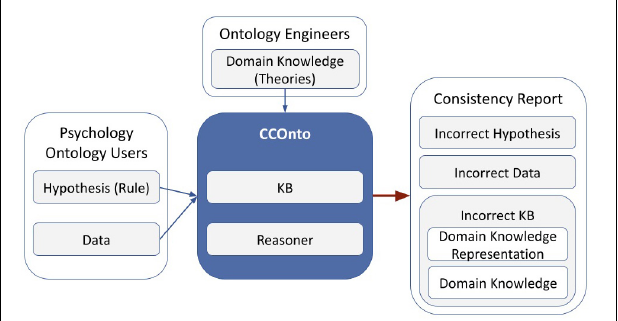
FIGURE 4 | An overview of a psychologically driven usage scenario of the ontology-based theoretical